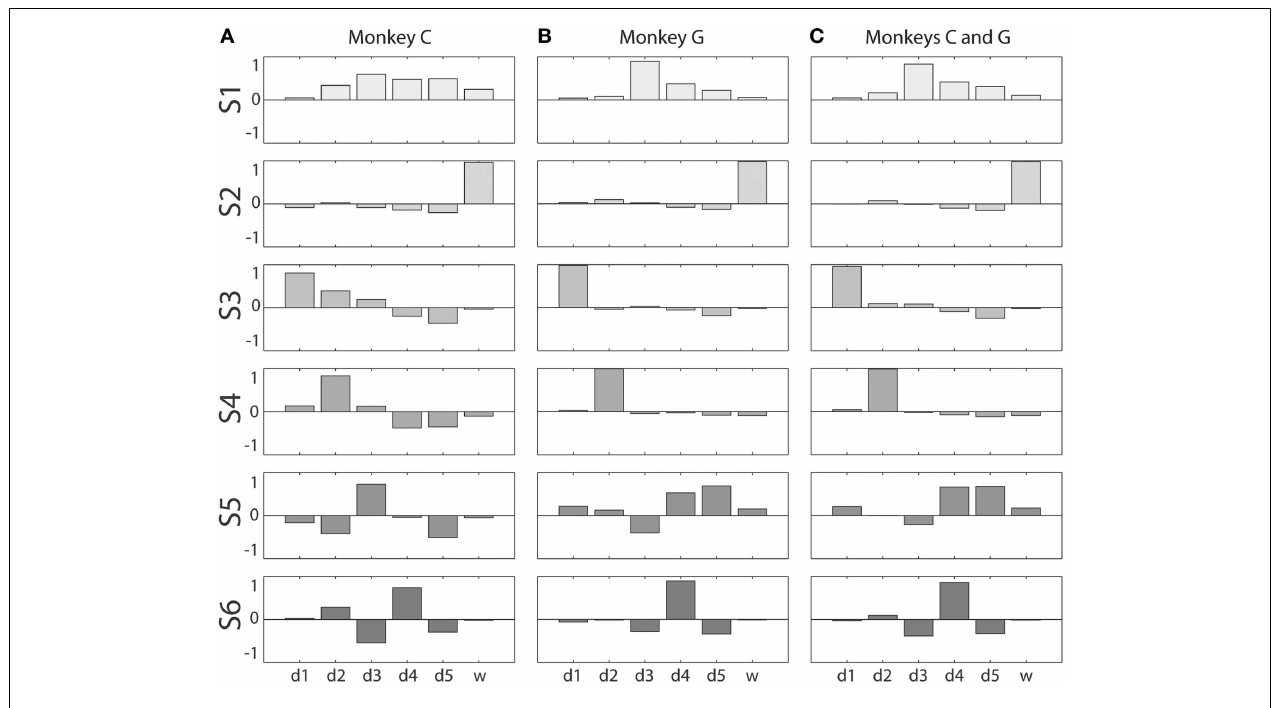
resulting from the same process applied to the eigenvectors from all sessions from both monkeys together.Within each bargraph, the six bars represent the six components of that synergy’s eigenvector projected onto each of the six original DoF axes, from d1 through